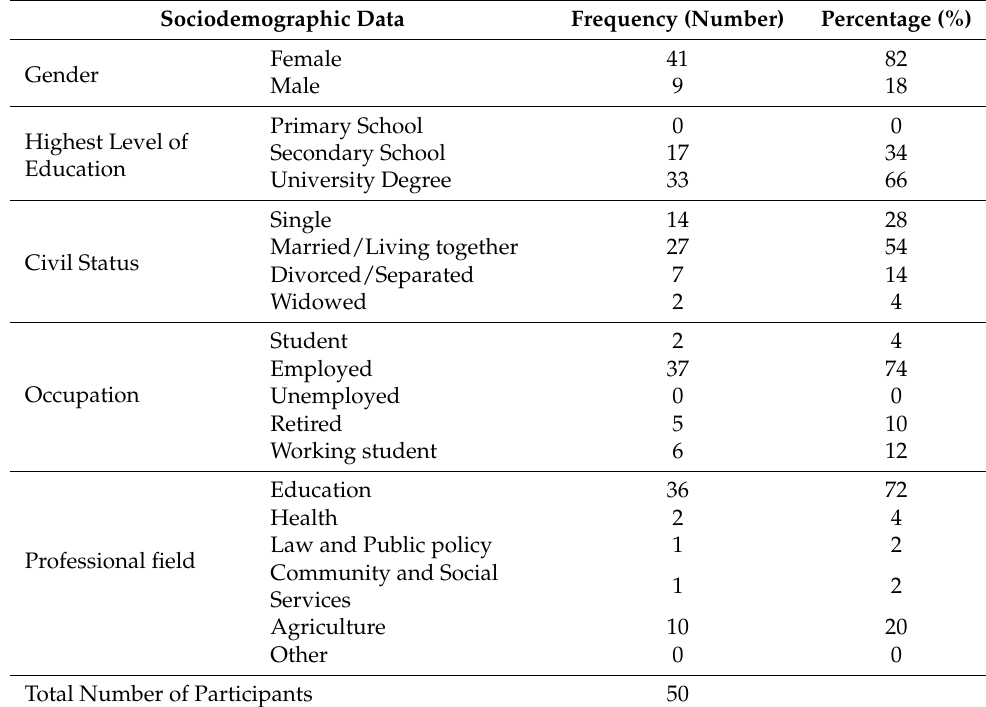
Table 1. Sociodemographic